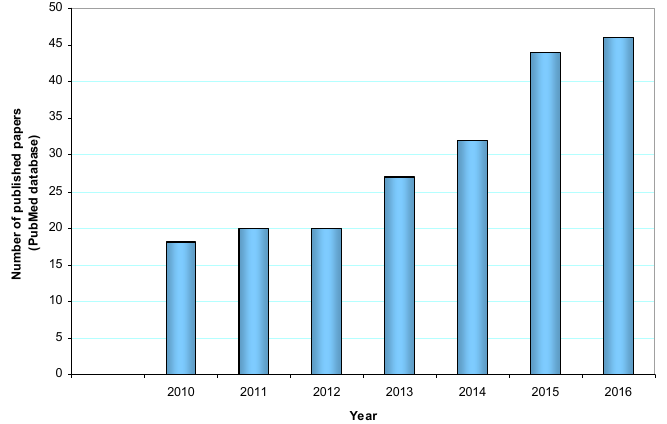
Figure 1. Number of papers on Litchi chinensis biological activities published in the last seven years (font PubMed database, https://www.ncbi.nlm.nih.gov/pubmed).